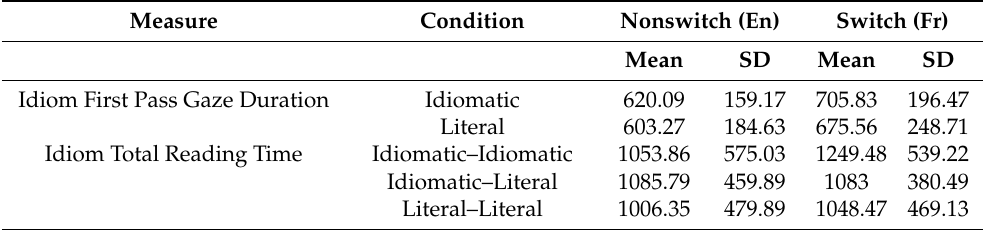
Table 8. Subject-aggregated means and standard deviations (in milliseconds) for raw Idiom First Pass Gaze Duration and raw Idiom Total Reading Time (Experiment 2) across sentence conditions containing nonswitched English (En) nouns and nouns switched to French